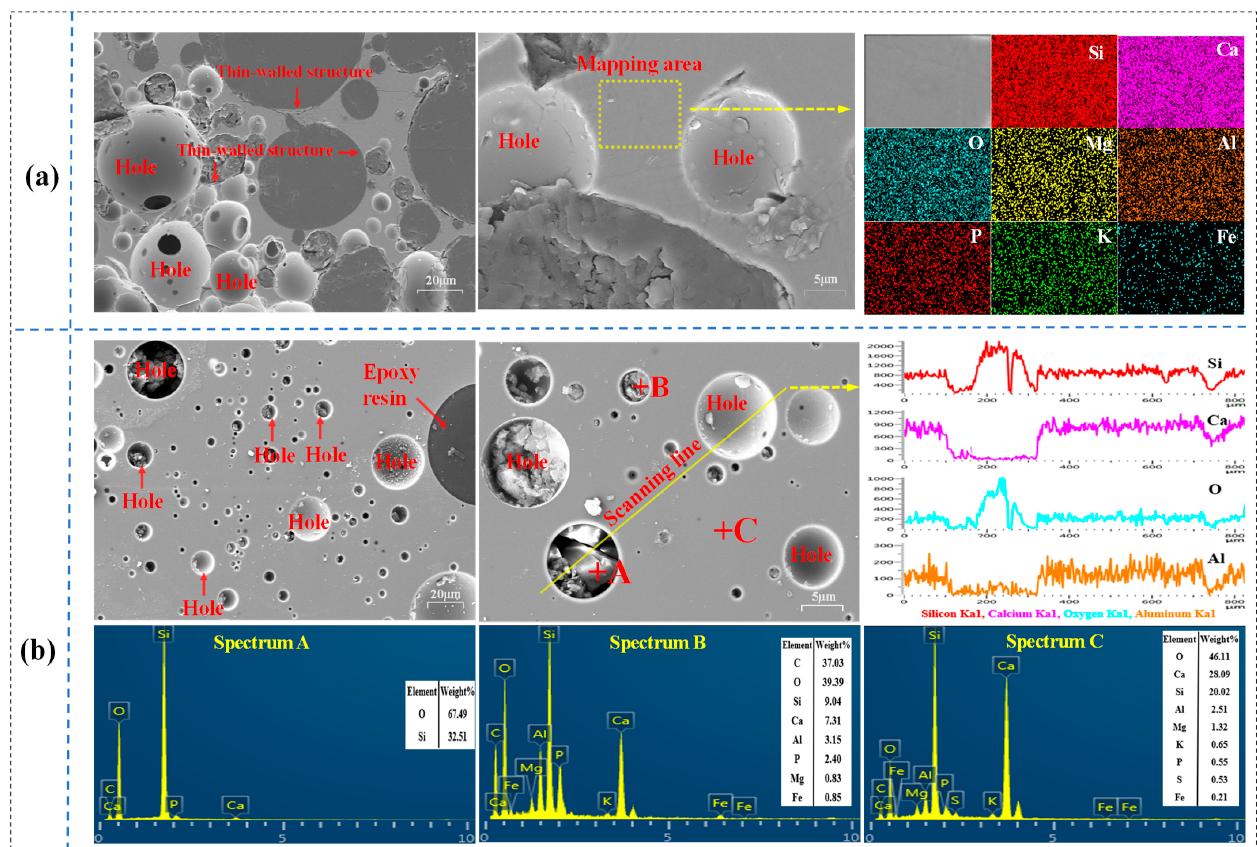
Figure 6. SEM-EDS analyses of the mixtures with an acidity of 0.92 smelted at 1450 °C for 60 min in pure N 2 (99.99%) atmosphere. ( a ) Water quenching; ( b ) Air cooling.